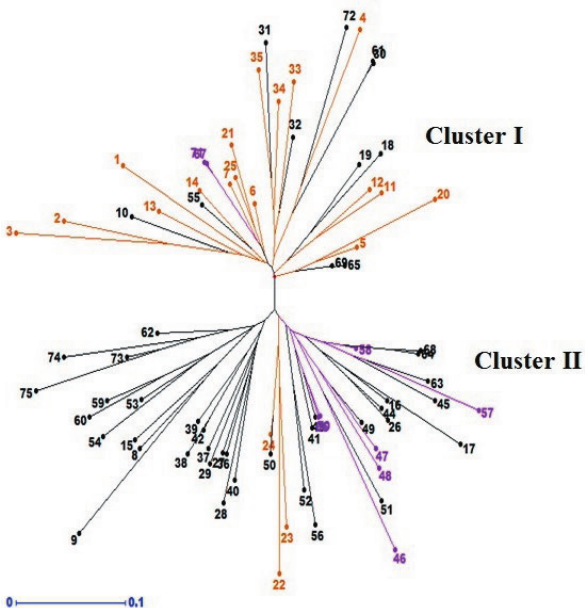
Figure 1. Neighbor joining (NJ) phylogenetic tree from pooled ISSR and SSR molecular data for 75 Ascochyta rabiei isolates col- lected from the western Iran provinces of Kermanshah (black), Kurdistan (red) and Lorestan